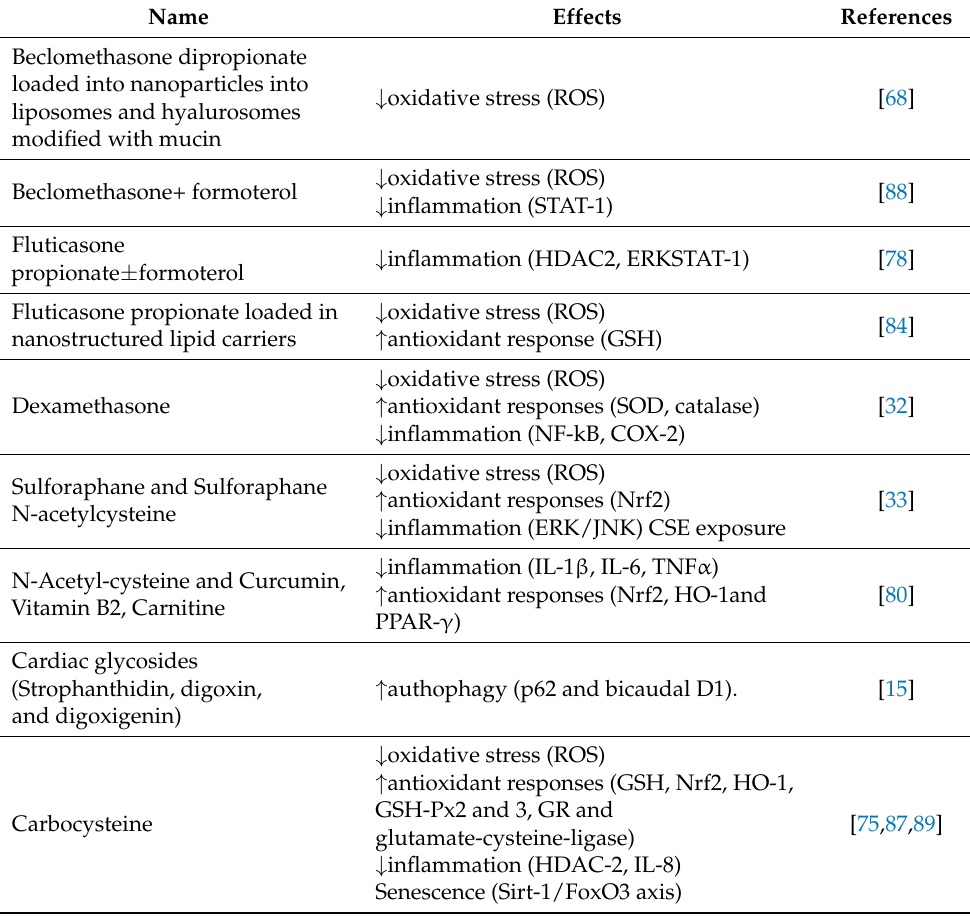
Table 2. Synthetic antioxidant